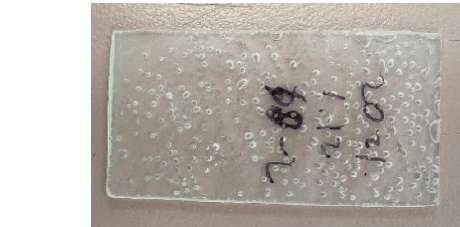
Figure 14. MLR experimentation samples. Left: control (0 kGy)-no visible pores; Right: 56 kGy gamma dose pre-irradiated – showing visible pores.